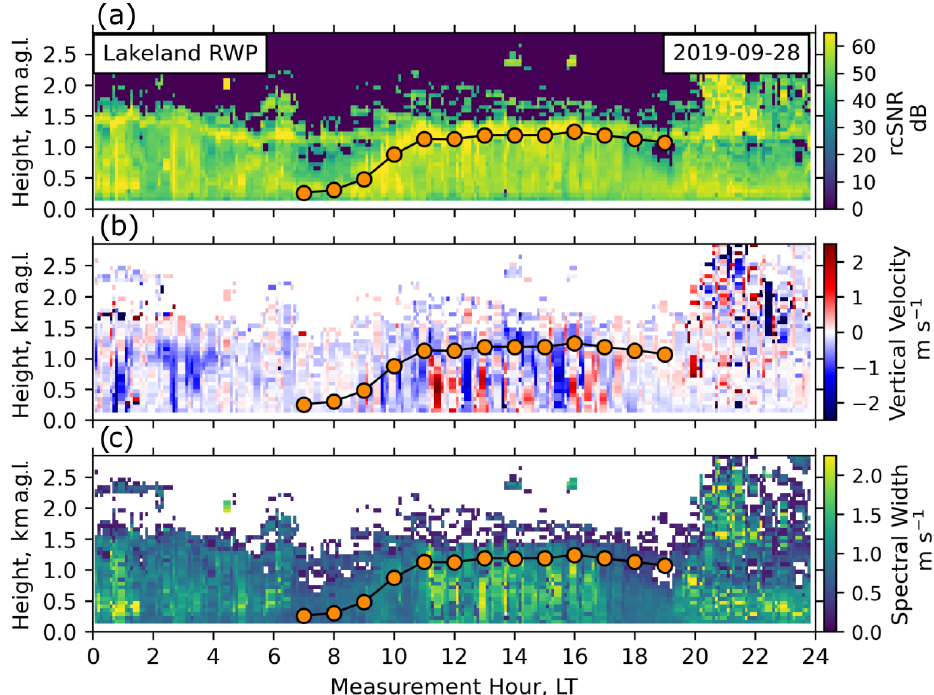
Figure 7. Time–height cross section of the RWP measurements used to determine the PBLH estimates at Lakeland for 28 September 2019: (a) range-corrected SNR, (b) vertical velocity (positive indicates downward motion), and (c) spectral width of the vertical velocity. Overlaid on each of these subplots are the fuzzy-logic-based hourly mean PBLH estimates (orange dots) during the